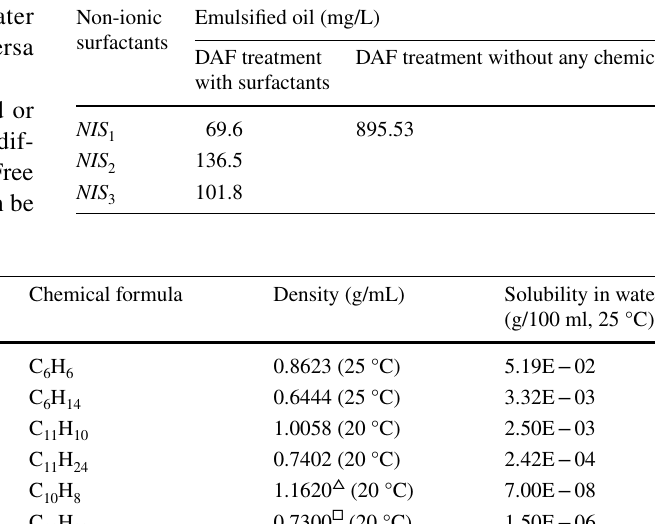
Table 4 Effect of the three non-ionic surfactants on removing of emulsified